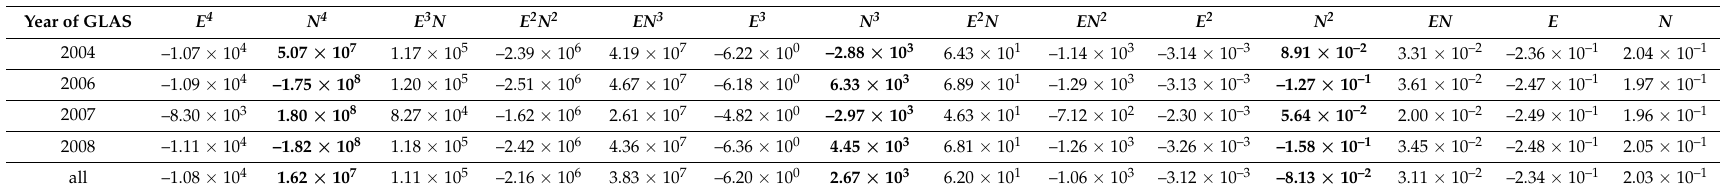
Table 5. Coefficients of fitted glacier surface using different year of GLAS data and SRTM DEM. E, N are the variables of polynomial function and the different combination of E, N are the different terms of polynomial function (Equation